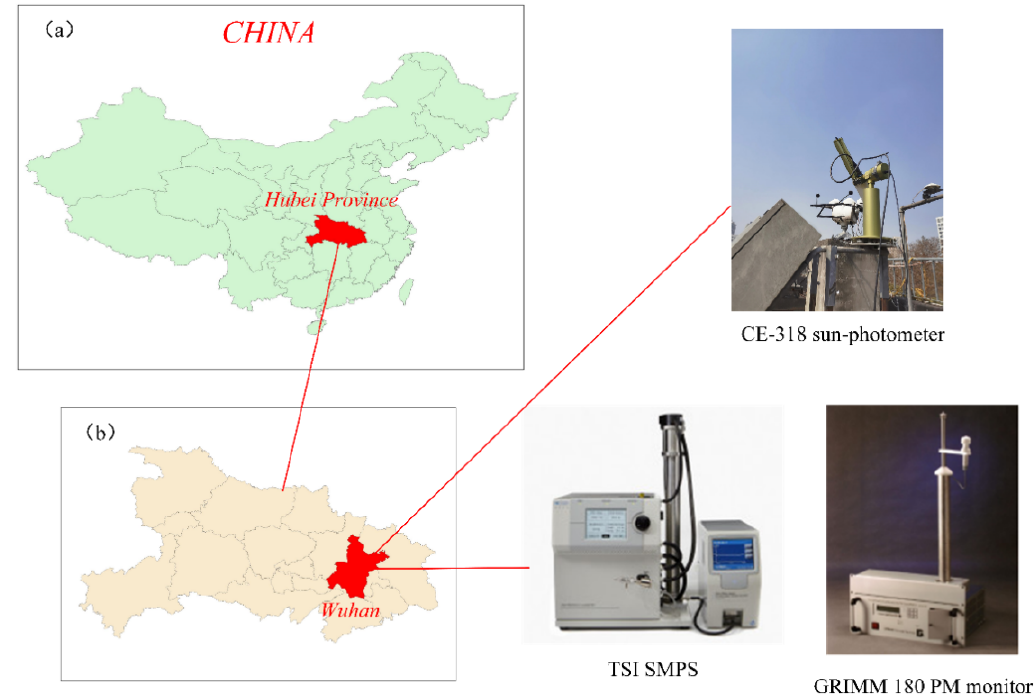
Figure 1. Location of instruments: ( a ) location of Hubei Province in China; ( b ) location of Wuhan in Hubei Province; and the three instruments used in this study, including CE-318 sun photometer, GRIMM 180 PM (particulate matter) monitor, and TSI SMPS (scanning mobility particle sizer).